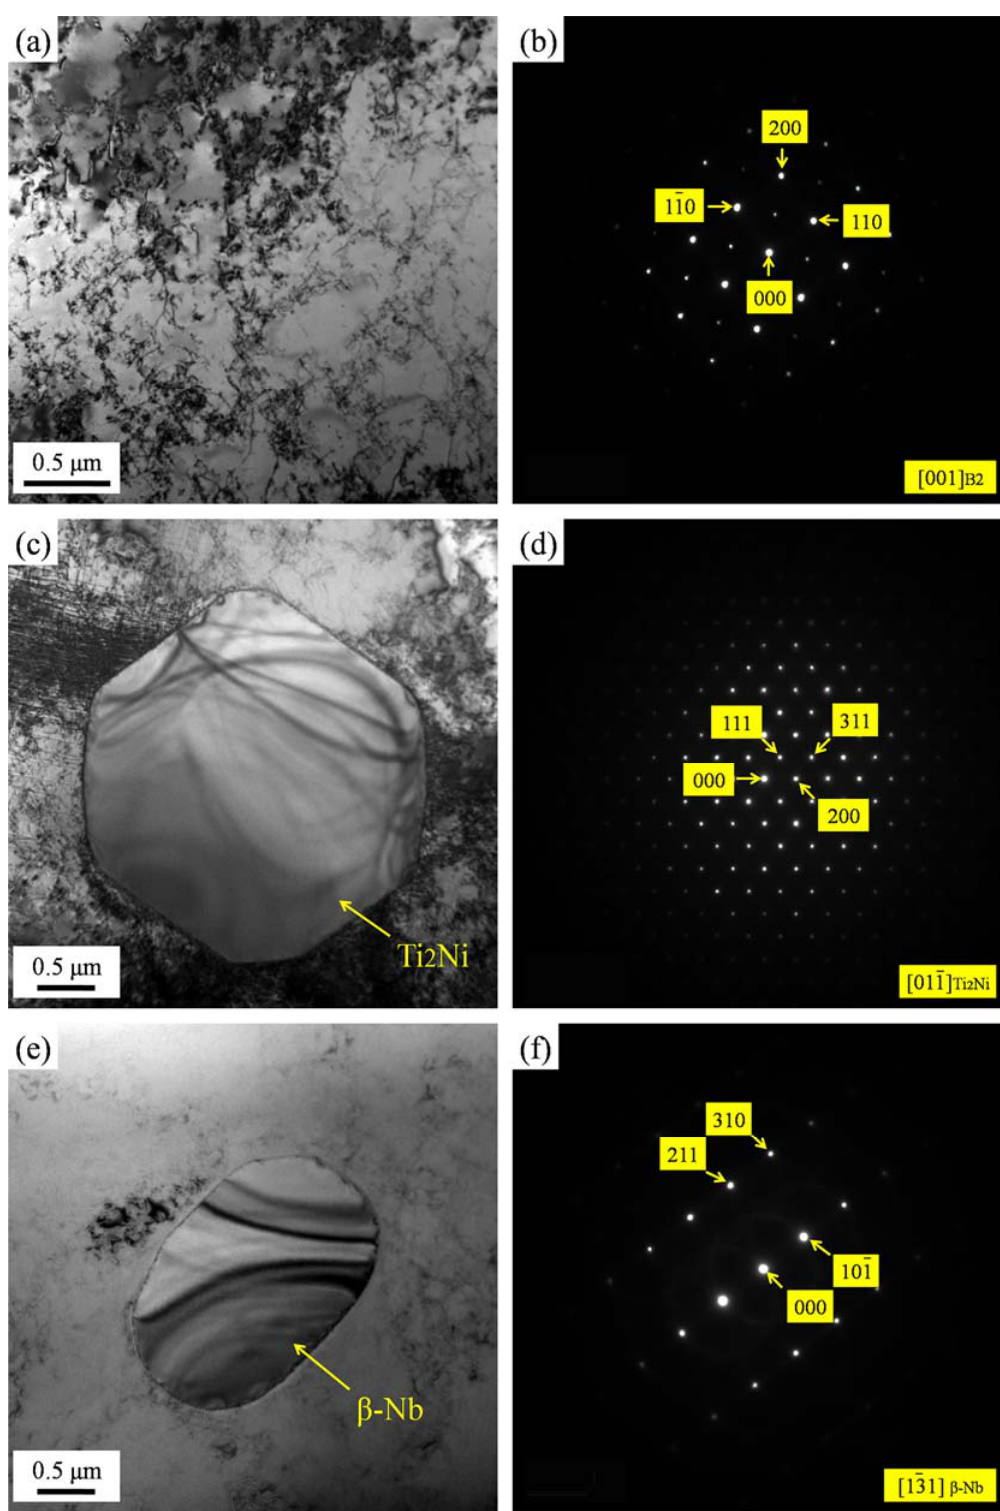
Figure 4. TEM micrographs of Ni 44 Ti 51.8 Fe 3.2 Nb 1 SMA: ( a ) Bright field image showing B2 austenite matrix; ( b ) Diffraction pattern of B2 austenite matrix in ( a ); ( c ) Bright field image showing Ti 2 Ni precipitate; ( d ) Diffraction pattern of Ti 2 Ni precipitate in ( c ); ( e ) Bright field image showing β‐ Nb precipitate; ( f ) Diffraction pattern of β‐ Nb precipitate in ( e ).